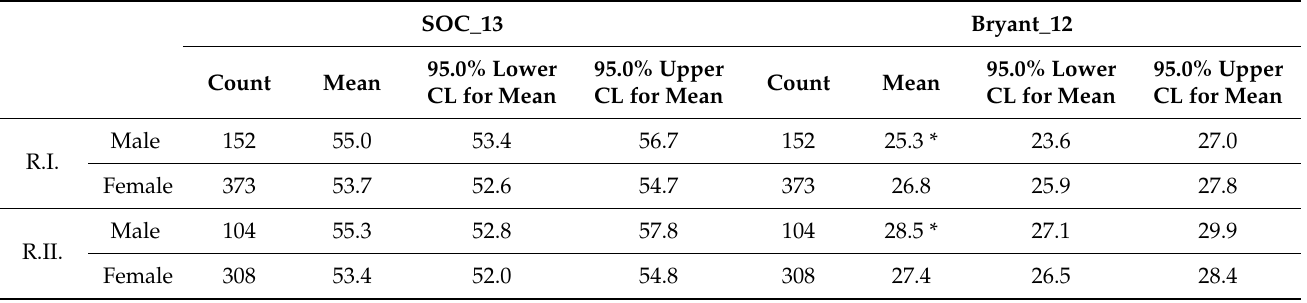
Table 3. Statistical characteristics of the samples by gender in SOC13 and